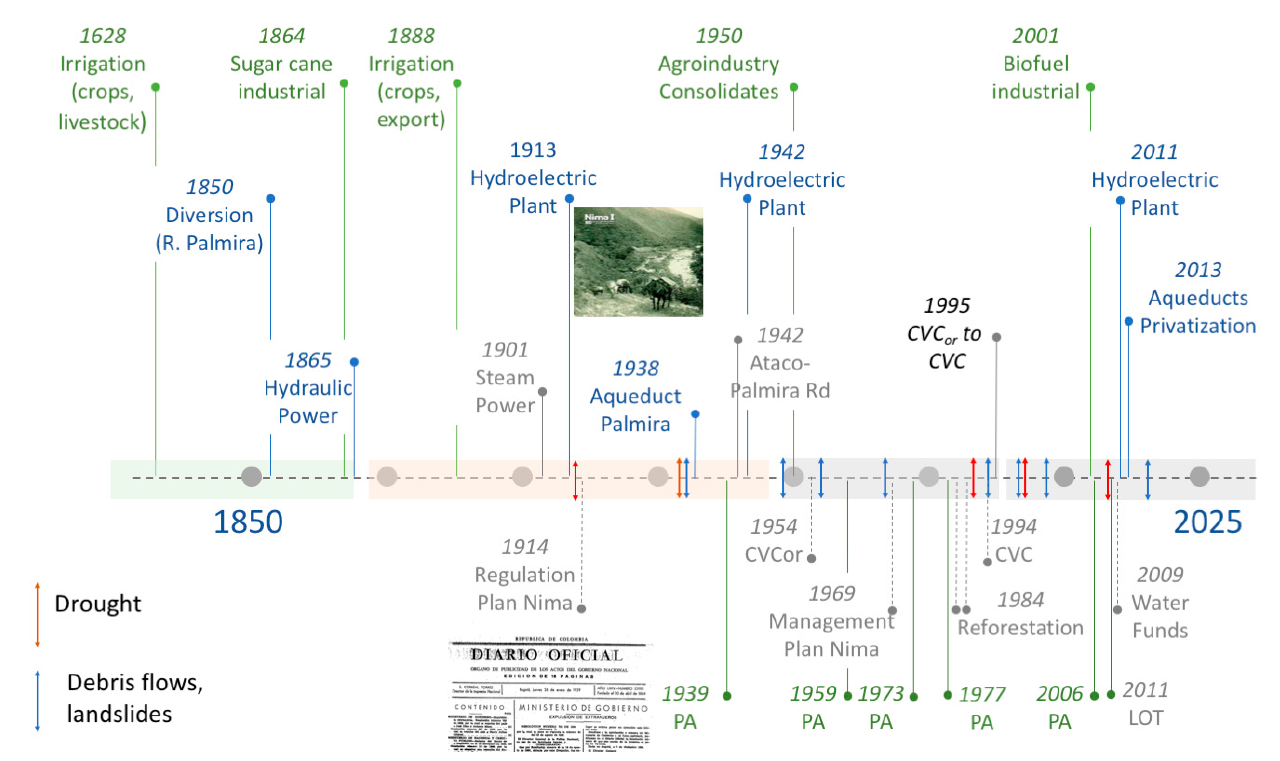
Figure 3. Time-line showing economic, infrastructure, policy/legal, and climatic events that shaped the use of water-derived ecosystem services (WES) in the Nima and neighboring watersheds, Valle del Cauca, Colombia. The horizontal green, pink, and grey bars denote three periods that differ in terms of water management and demand, supply, and distribution of WES: colonial manorial hacienda (green), transition to agroindustry (pink), and consolidation of agroindustry (grey); the latter has been subdivided into two sub-periods associated with major institutional transformations. PA: Protected Areas irrespective of type, LOOT: Ley Orgánica de Ordenamiento Territorial (Organic Law of Territorial Planning).